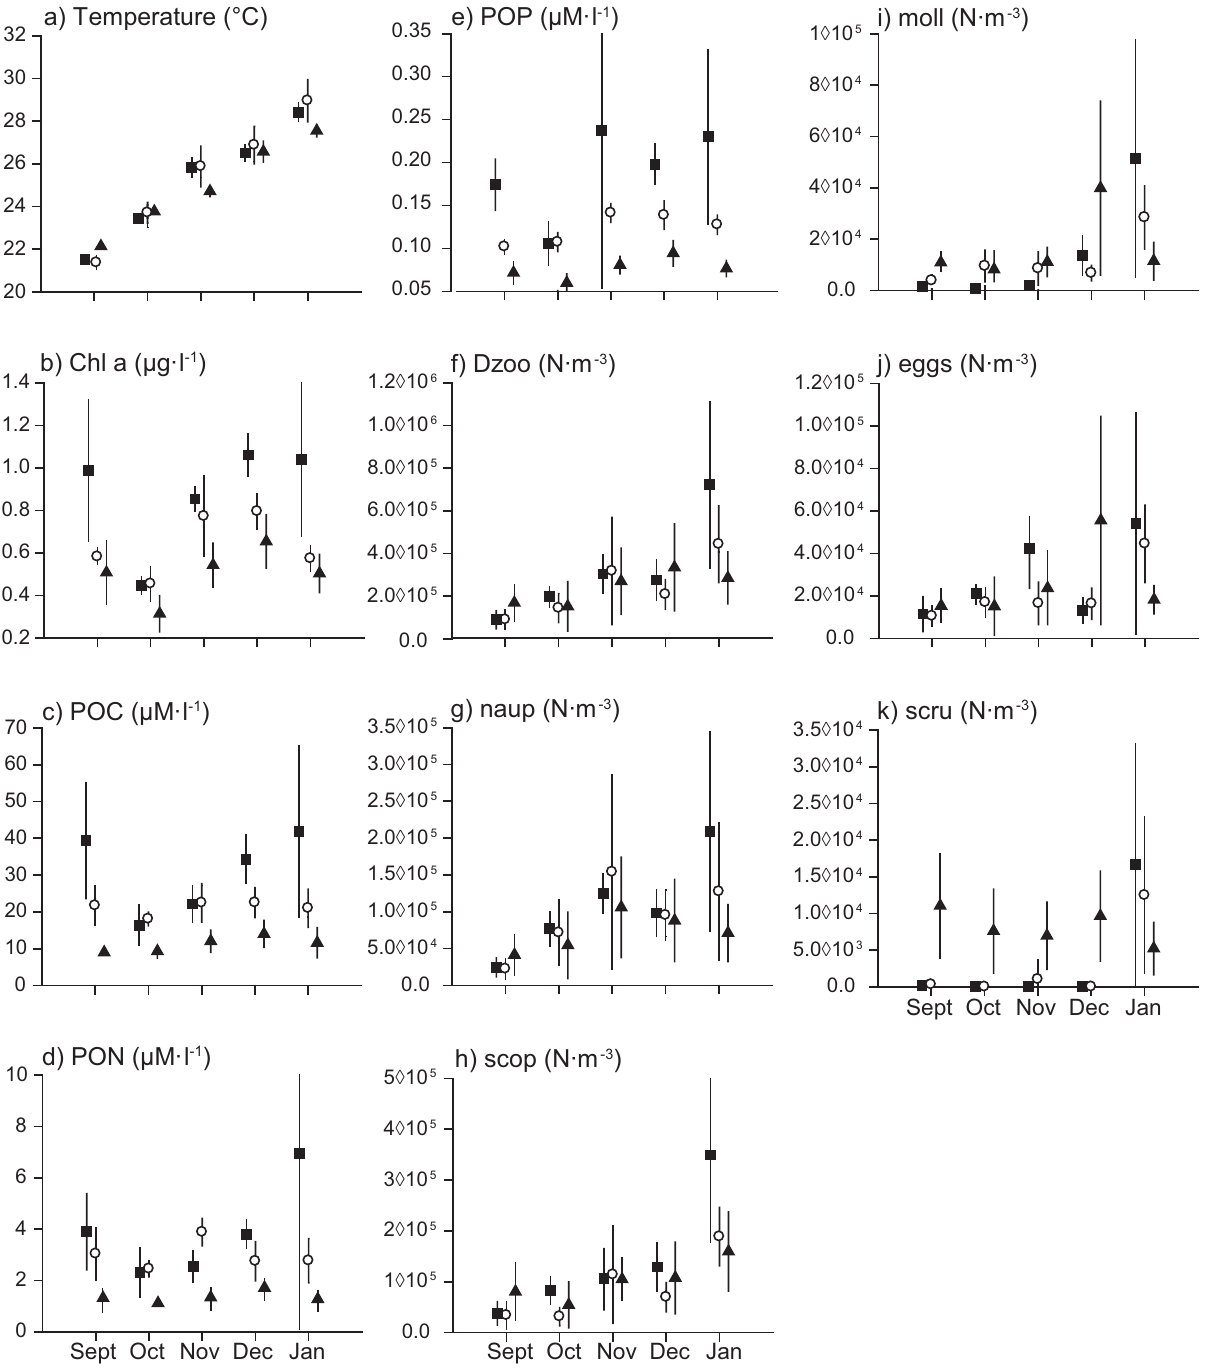
F IG . 3. – Monthly means and standard deviations in each bay for the five water column and six zooplankton variables retained based on their contribution in the PCA (Fig. 2). White circles: Bay of Chambeyron, black squares: Bay of Ouaraï; black triangles: Bay of